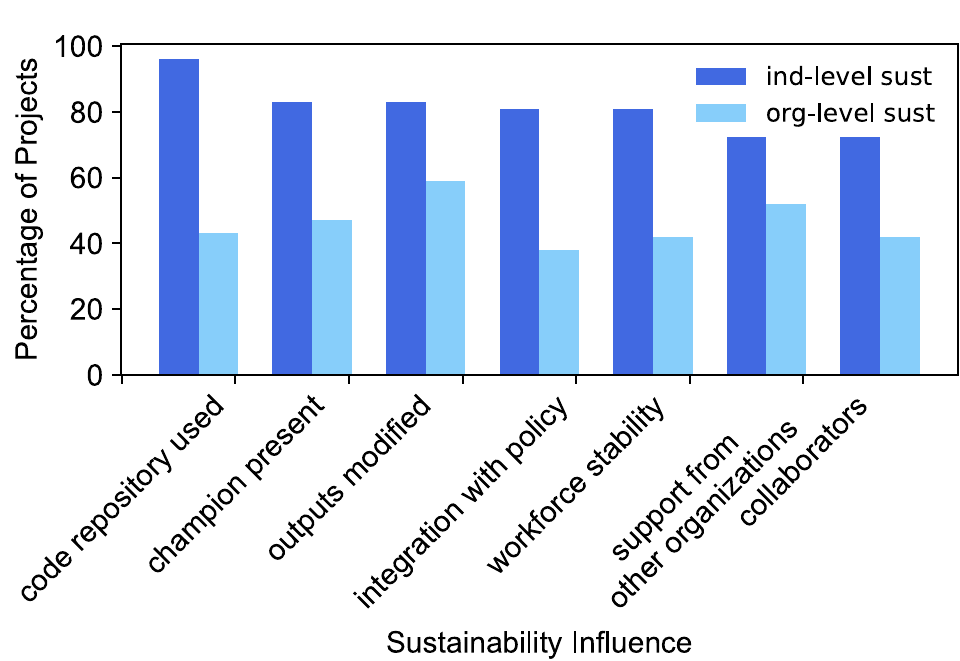
Fig 7. Percentage of projects with specific sustainability influences that reached individual-level and organization- level sustainability. Medium blue: projects with individual-level sustainability, light blue: projects with organization-level